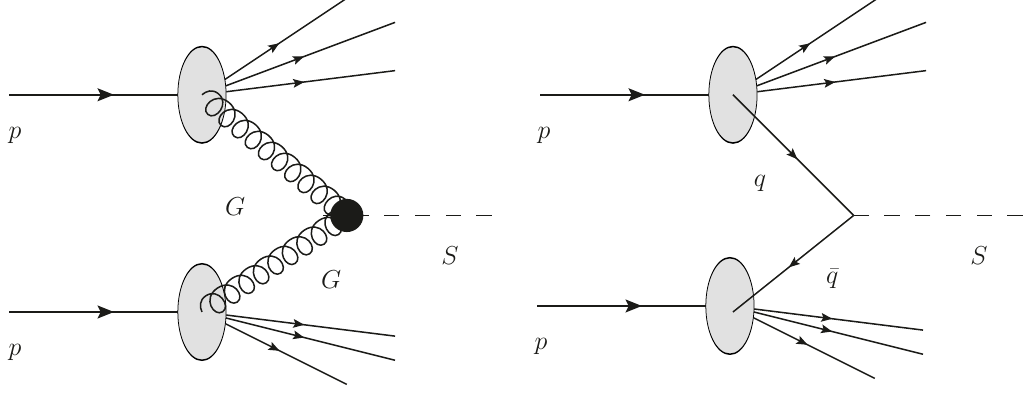
Figure 14 . The diagrams of the production of the scalar in deep inelastic